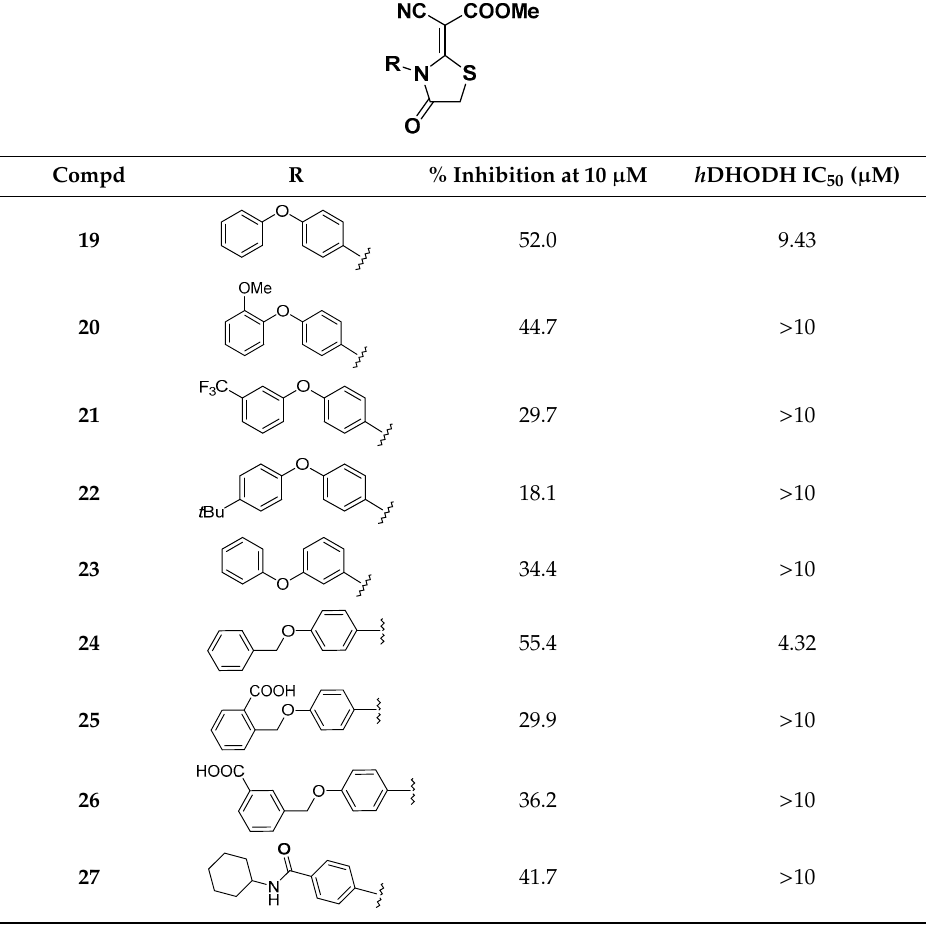
Table 2. Structures and activities for 4-thiazolidinone analogs 19 – 46.